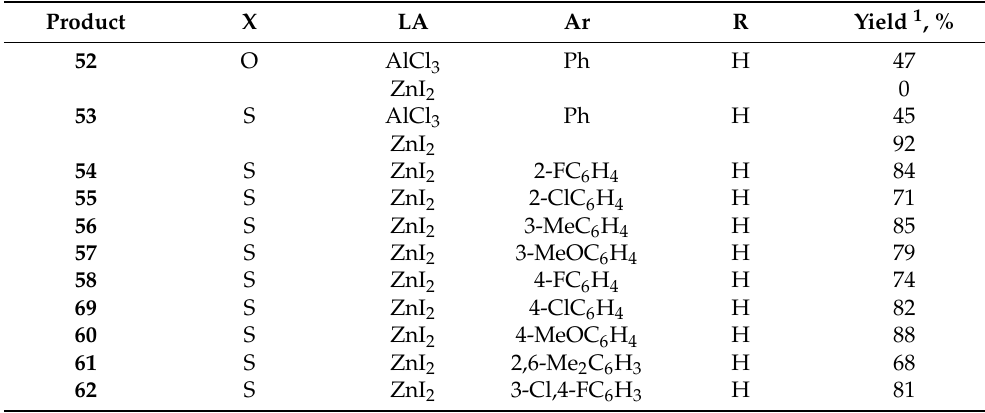
Table 3. Diels–Alder reactions of methylideneimidazolones with